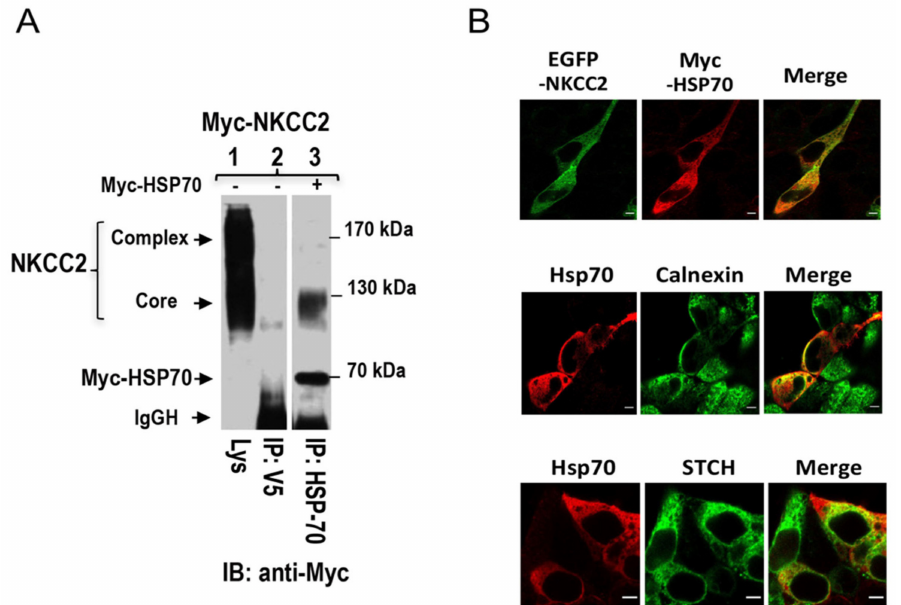
Figure 6. NKCC2 interacts with the stress-inducible Hsp70. ( A ) Hsp70 interacts also with immature NKCC2. Cell lysates from OKP cells transiently transfected with Myc-NKCC2 singly or in com- bination with of Myc-Hsp70 were immunoprecipitated (IP) with anti-Hsp70 or anti-V5 antibody. NKCC2 protein was recovered from Hsp70 immunoprecipitates only in its immature form ( lane 3 ). ( B ) Similar to STCH, Hsp70, and NKCC2 co-localizes at the ER. Upper panel , immunofluorescence confocal microscopy showing distribution of NKCC2 and Hsp70 in HEK cells. Transiently transfected HEK cells with EGFP-NKCC2 and Myc-HSP70, were fixed, permeabilized, and then stained with mouse anti-Myc for NKCC2 (Texas Red). The yellow color (merged image) illustrates co-localization of the proteins. Middle panel , HEK cells transfected with Myc-Hsp70 were stained with mouse anti-Myc (Texas Red; red) and rabbit anti-calnexin (FITC; green). Yellow indicates overlap between Hsp70 (red) and the ER marker (green). Lower panel , STCH colocalizes with Hsp70. HEK cells transiently transfected with GFP-STCH and Myc-Hsp70, were fixed and permeabilized before being stained with mouse anti-Myc for Hsp70 (Texas red, Red). Yellow illustrates overlap between Hsp70 (red) and the STCH (green). Bars, 5 µ